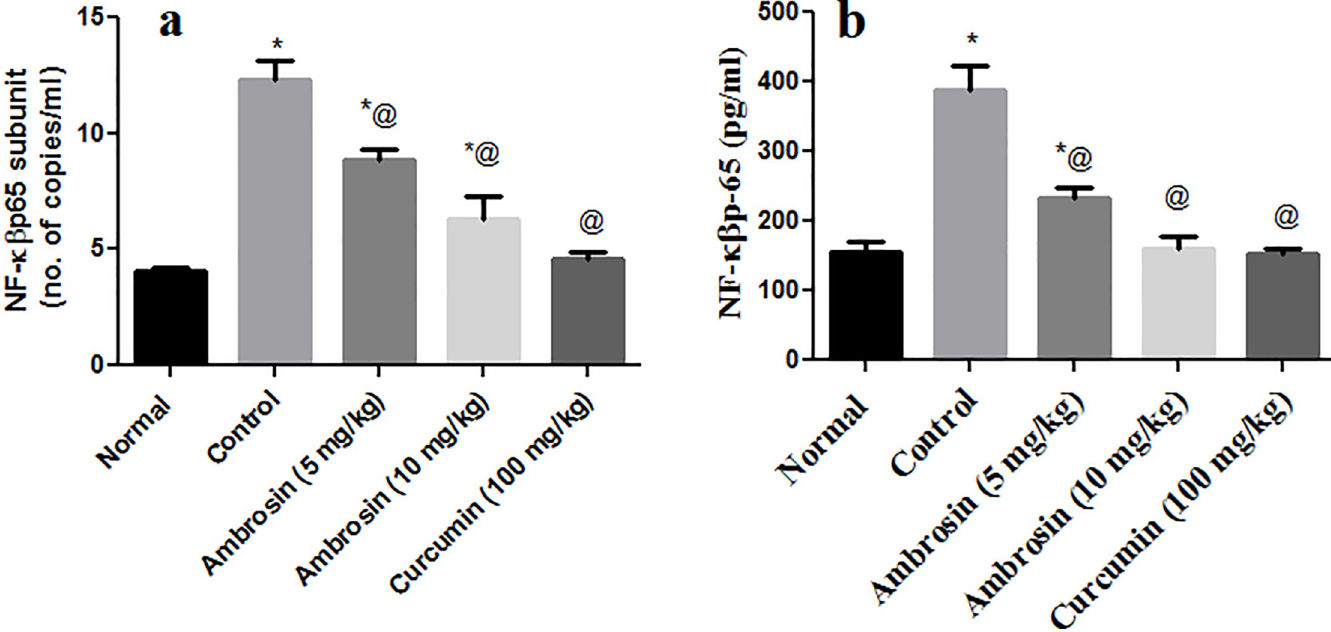
Fig 4. Suppression of NF- κβ p65 transcript (a) and protein levels (b) by curcumin and ambrosin administration. Data represented mean ± SEM (n = 6). Statistical analysis was performed using one-way ANOVA followed by Tukey‘s multiple comparison test. � Significantly different from normal group at P < 0.05. @ Significantly different from control group at P <